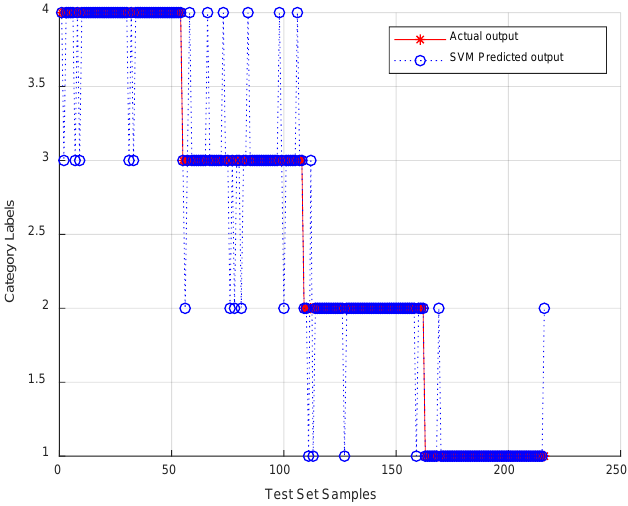
Figure 13. DE-ELM (200 nodes)-based fatigue state detection results.